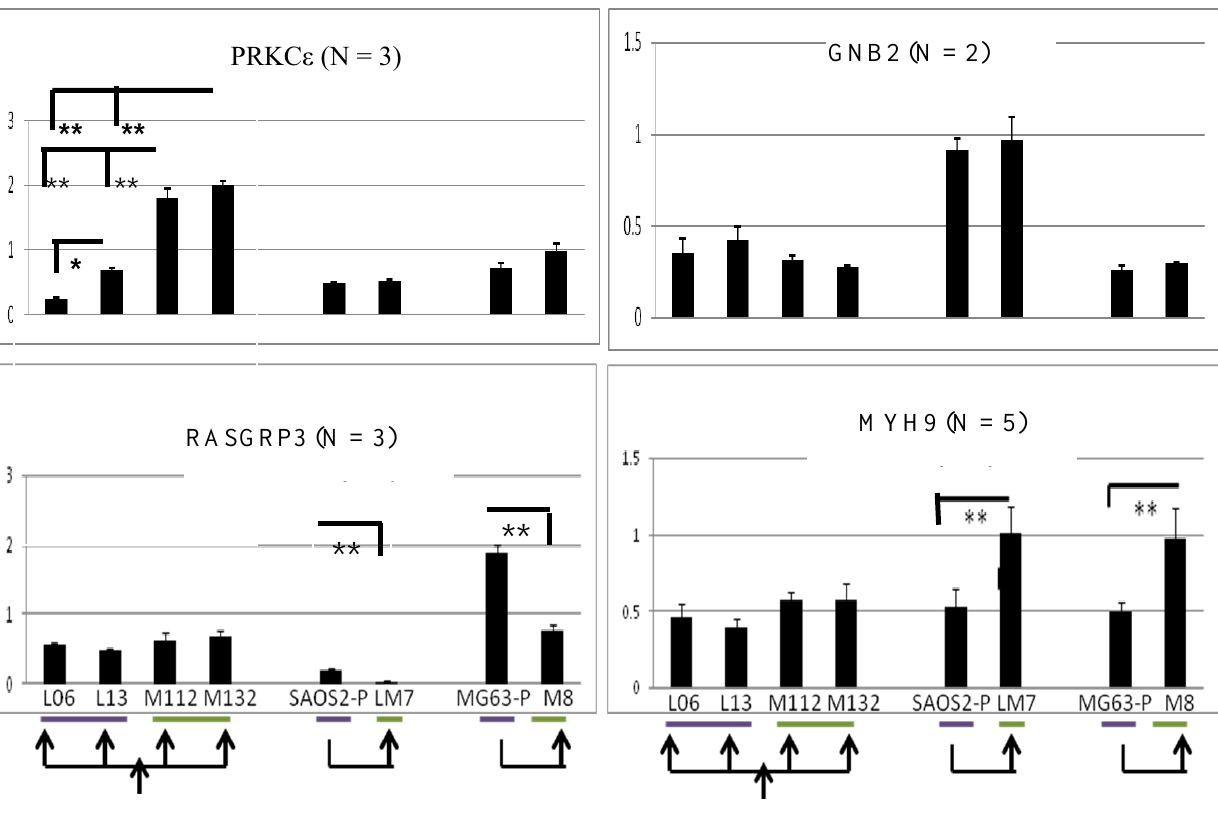
Figure 6. The PRKCε-RASGRP3-GNB2 network is differentially activated in vitro. Quantitative PCR was performed on cDNA synthesized from the human OS cell lines shown. Purple bars denote cell lines that are poorly metastatic in mouse models, and green bars denote cell lines that are strongly metastatic as murine xenografts. Arrows denote relationships between cell lines. Student’s t-test: * p ≤ 0.05 ** p ≤ 0.001. Multiple independent experiments are shown for each gene: GNB2 (n = 2), PRKC ε and RASGRP3 (n = 3), and MYH9 (n = 5). ** p ≤ 0.001, * p ≤ 0.05.